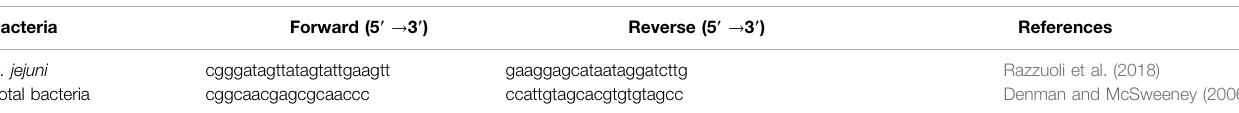
TABLE 2 | The list of the primers used for ileum microbial population analysis.